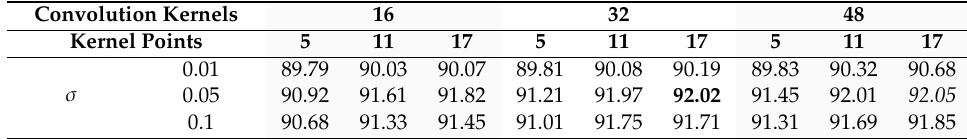
Table 4. Classification accuracy (%) of SAPointNet on the ModelNet40 dataset with di ff erent parameters.